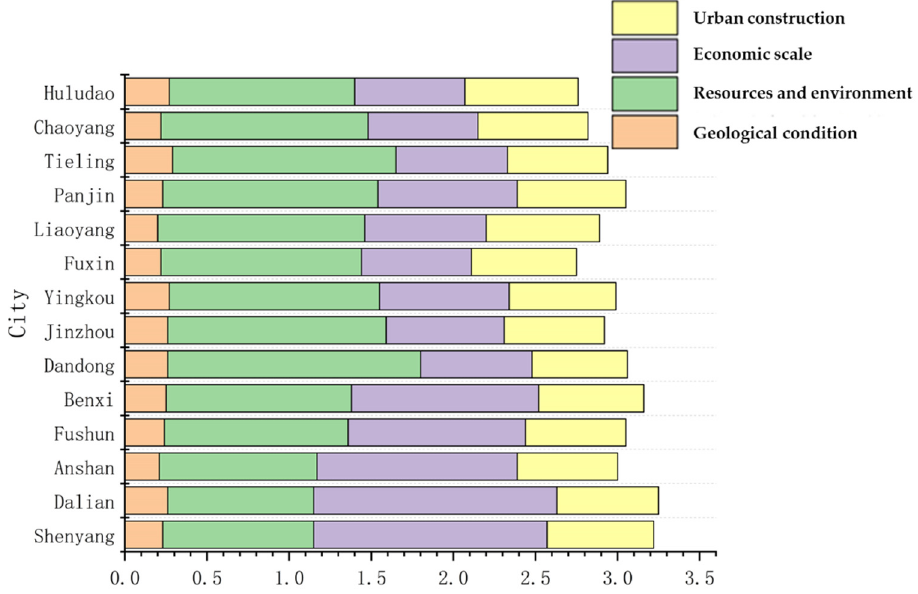
Figure 4. Stacking histogram of LCCC subsystem.